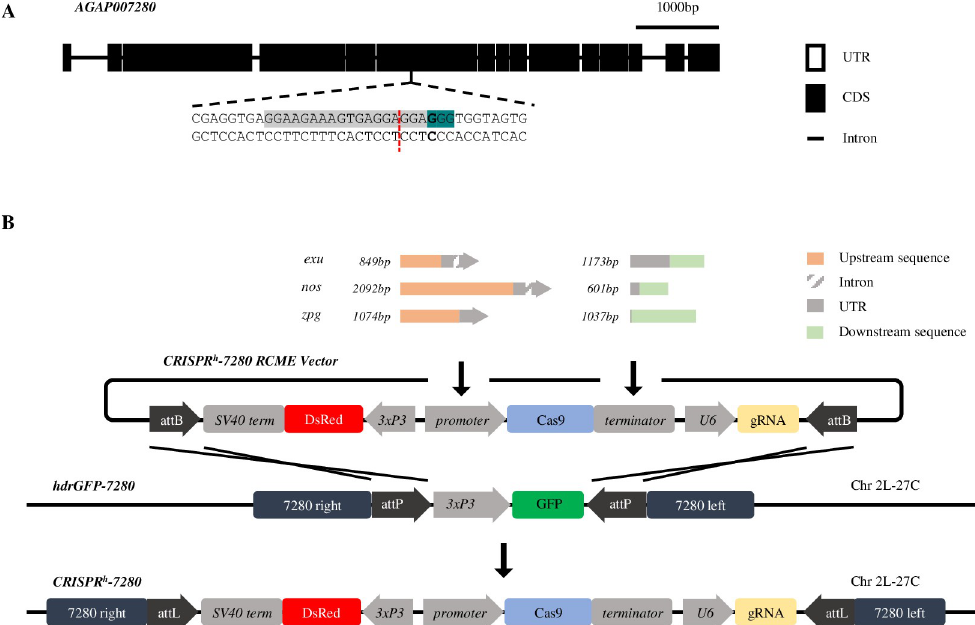
Fig 1. Target site and design of new CRISPR h gene drives designed to express Cas9 under regulation of zpg , nos and exu germline promoters. (A) The haplosufficient female fertility gene, AGAP007280 , and its target site in exon 6 (highlighted in grey), showing the protospacer-adjacent motif (highlighted in teal) and cleavage site (red dashed line). (B) CRISPR h alleles were inserted at the target in AGAP007280 using φ C31-recombinase mediated cassette exchange (RMCE). Each CRISPR h RMCE vector was designed to contain Cas9 under transcriptional control of the nos , zpg or exu germline promoter and terminator, a gRNA targeted to AGAP007280 under the control of the ubiquitous U6 PolIII promoter, and a 3xP3 :: DsRed